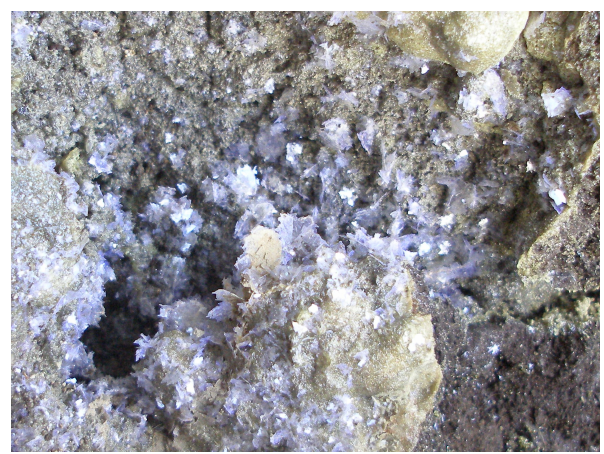
Figure 1. Violet flakes of freitalite on sulfur from the mine dump of the Königin Carola shaft, Freital, near Dresden, Saxony, Germany. Picture width is